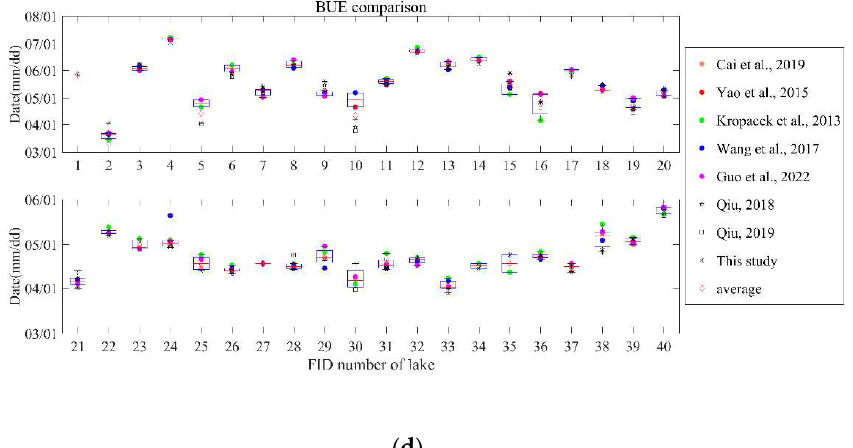
Figure 2. ( a ) Average freeze-up start date (FUS) of 40 lakes in different datasets. The solid-colored dots are the results obtained from MODIS data, the hollow figures with black borders are the results obtained from passive microwave data, and the red diamonds are the multi-source average of all the results. FID numbers are shown in Table 1. ( b ) Average freeze-up end date (FUE) of 40 lakes in different datasets. The solid-colored dots are the results obtained from MODIS data, the hollow figures with black borders are the results obtained from passive microwave data, and the red dia- monds are the multi-source average of all the results. FID numbers are shown in Table 1. ( c ) Average break-up start date (BUS) of 40 lakes in different datasets. The solid-colored dots are the results obtained from MODIS data, the hollow figures with black borders are the results obtained from passive microwave data, and the red diamonds are the multi-source average of all the results. FID numbers are shown in Table 1. ( d ) Average break-up end date (BUE) of 40 lakes in different datasets. The solid-colored dots are the results obtained from MODIS data, the hollow figures with black borders are the results obtained from passive microwave data, and the red diamonds are the multi- source average of all the results. FID numbers are shown in Table 1 [18,30–32,47,50,51].